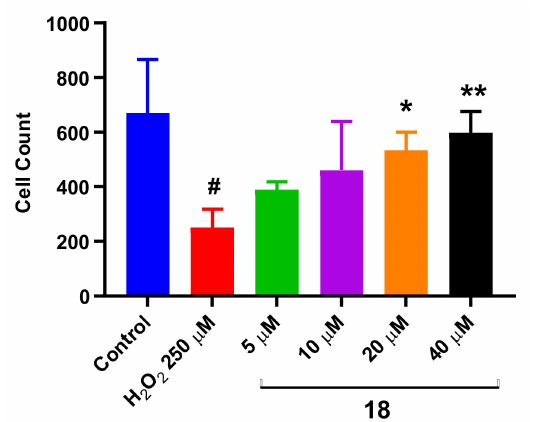
Figure 12. Neuroprotection effect of compound 18 against H 2 O 2 induced cytotoxicity in SH-SY5Y cells. Compound was administered at different concentrations for 24 h prior to H 2 O 2 250 µ M treatment for another 24 h. A. After treatment, Calcein-AM was added and cells were counted from six fluorescent microscopy random images taken at 4 × from four different replicates of each compound concentration. ImageJ was used for cell counting. # p < 0.001 vs. vehicle- treated control. * p < 0.05, ** p < 0.01 vs. only with H 2 O 2 -treated